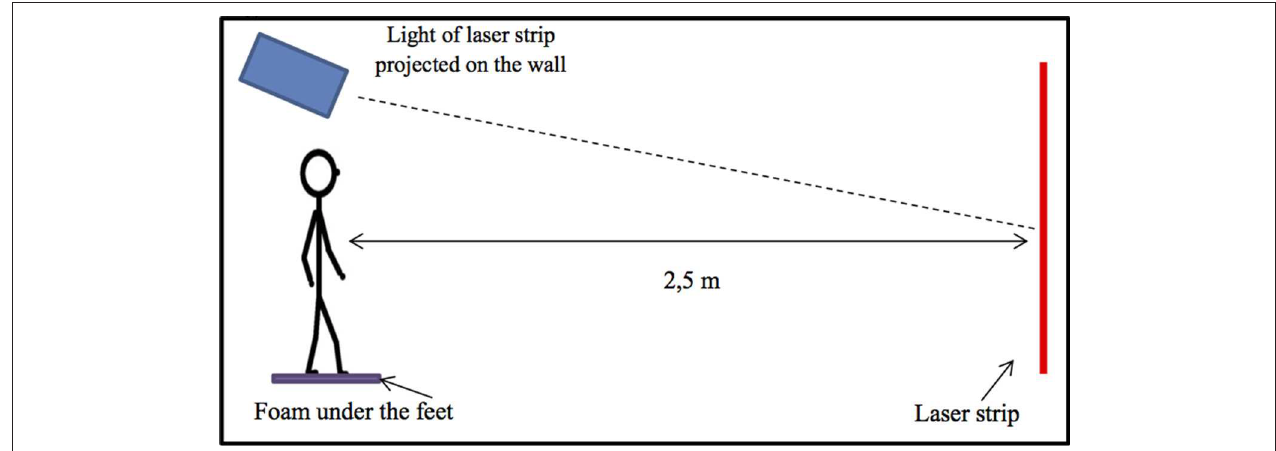
FIGURE 1 | Experimental set up used. The child is standing on with the feet on foam (Orthomic ® ), and the laser strip is projected on the wall in front of him/her. The laser strip can be tilted at 15 ◦ in clockwise (CW) and in counterclockwise (CCW) directions, and the child has to inform the experimenter when he/she perceived the laser strip vertical. The remote to the orientation of the laser strip is quiet and can be used step by step or in continuous movement.